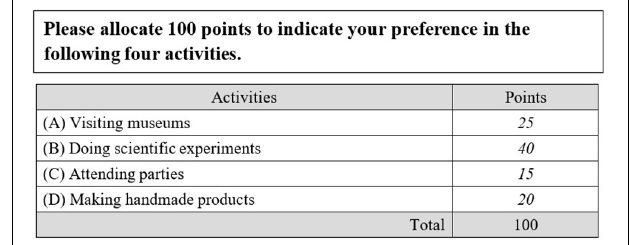
FIGURE 1 | Example of compositional